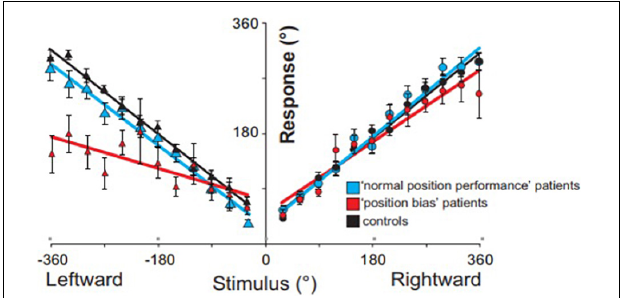
FIGURE 4 | Representative numerical clock drawings from a single subject during CALORIC + RIV stimulation: upper panel shows the drawings for the baseline condition (darkness), following RIGHTCOLD caloric only and RIGHTCOLD + RIV. Note the rightward lateral displacement of the numerical clock drawing following RIGHTCOLD + RIV. The lower panel shows the drawings for the baseline condition (darkness), following LEFTWARM caloric only and LEFTWARM + RIV. Note the leftward lateral displacement of the numerical clock drawing following LEFTWARM + RIV.